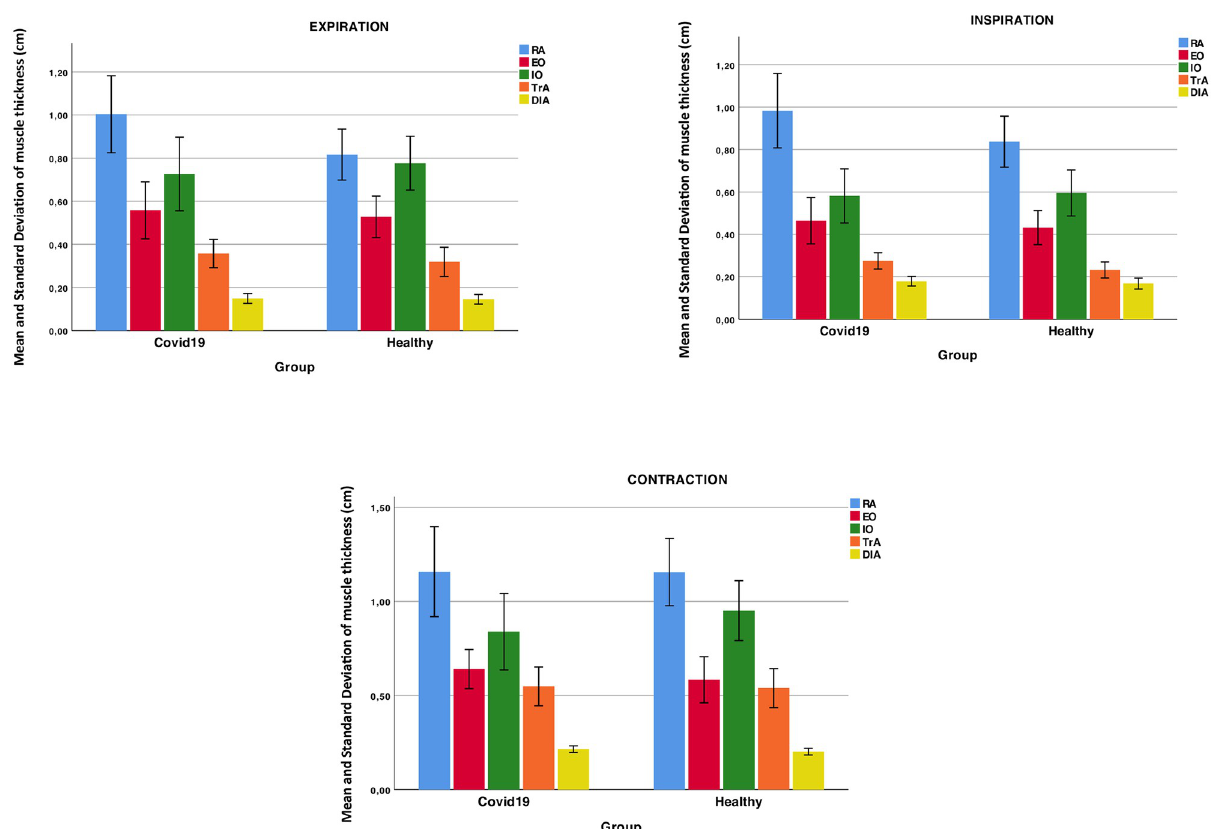
Fig 3. Ultrasonography comparisons between moderate Covid-19 infection and healthy participants.